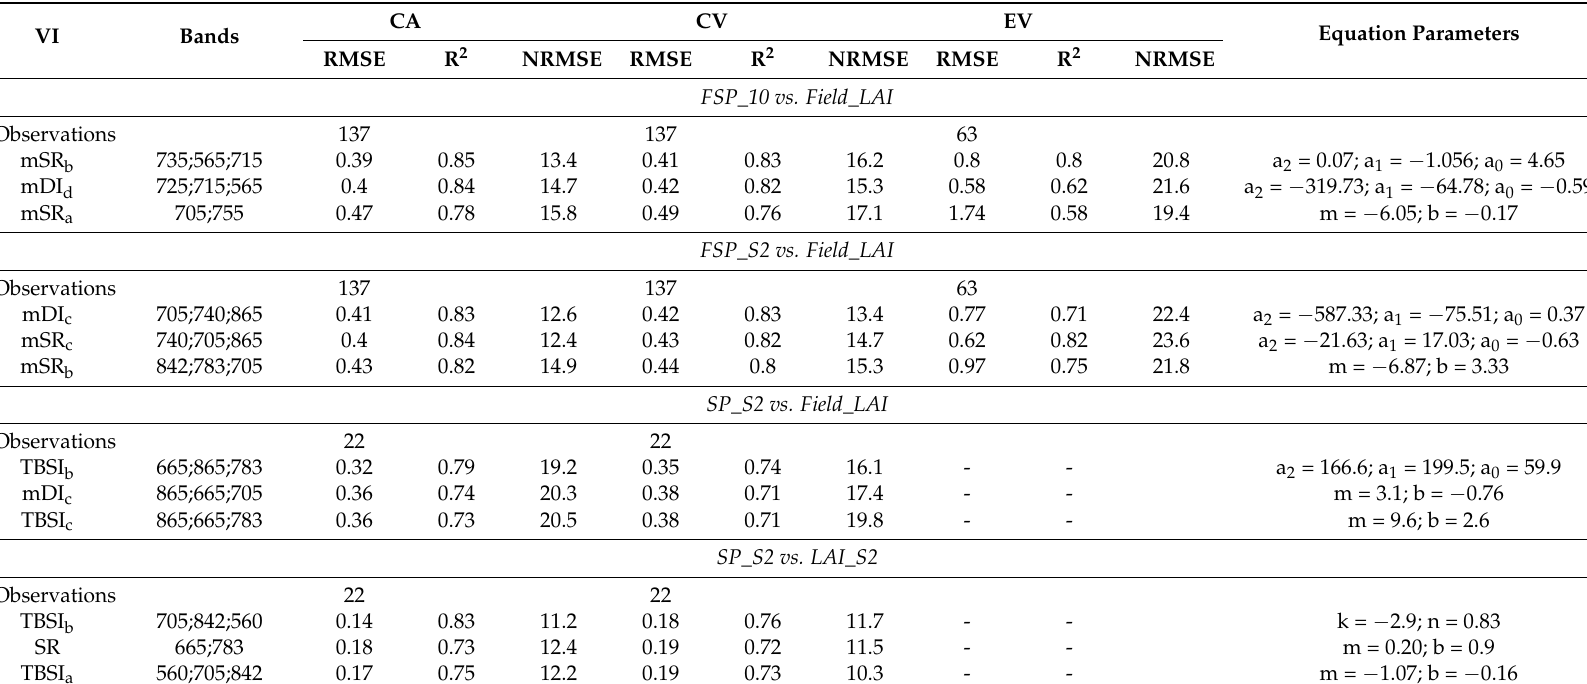
Table 6. Goodness-of fit statistics of the best performing vegetation indices (VI), using different combinations of spectral and leaf area index